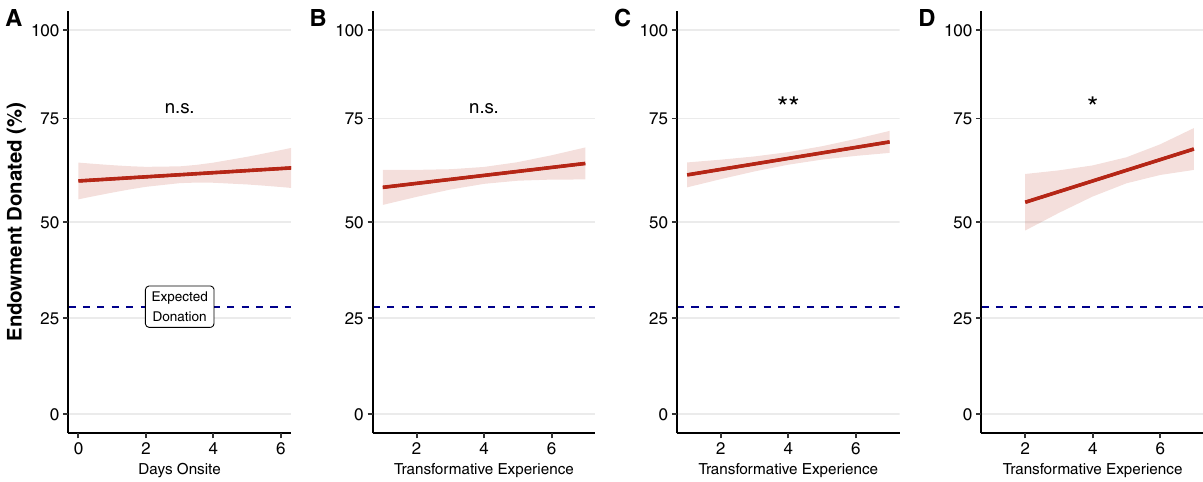
Fig. 4 Generosity during and after mass gathering attendance. A The relationship between days onsite and generosity; B – D The relationship between transformative experience and generosity during ( n = 785), immediately following ( n = 1810), and 6 months following ( n = 405) attendance. Generosity was assessed by providing participants with 10 tickets that would be redeemable for valuable prizes. Participants were given the opportunity to keep as many tickets as they wanted for themselves and give the rest to a randomly selected stranger. Lines show estimated marginal effects using multilevel linear models controlling for incidental variables with event set as a random factor (see analytic approach); signi fi cance values based on independently run two- sided t -tests on the resulting coef fi cients. Ribbons indicate 95% con fi dence intervals. Dashed blue lines re fl ect the expected level of generosity based on a published meta-analysis of Dictator games 56 ( n = 616 data points). ns not signi fi cant. ** p = 0.001; * p = 0.012. Source data are provided as a Source Data fi